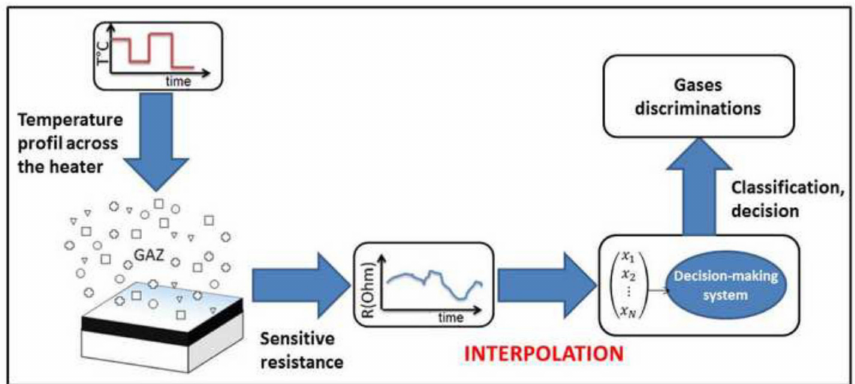
Figure 1. Interpolation principle of the gas sensors response.